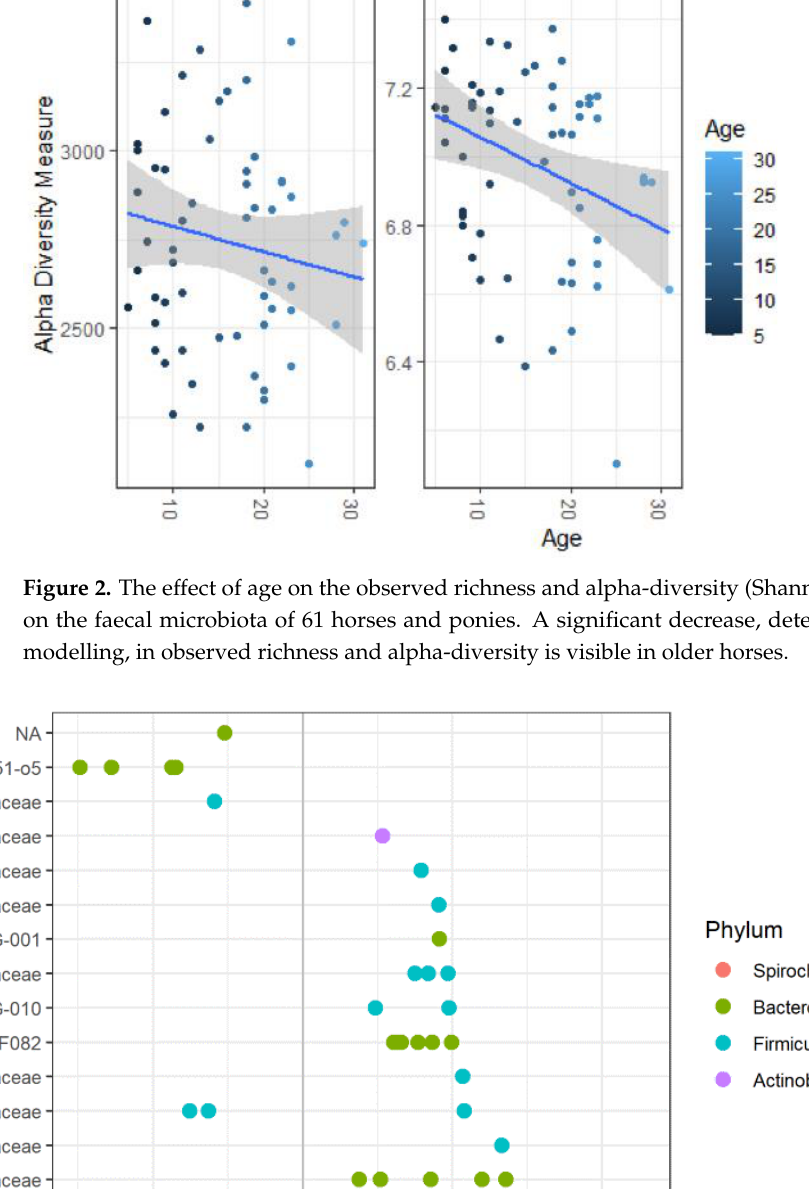
Figure 3. Differentially abundant ASVs grouped by family for increasing age (by year) of the faecal microbiota in 61 horses and ponies. The log2 fold change (per year) in ASV abundance is shown on the x -axis. ASVs assigned to bacterial families on the left side of the plot are less abundant in horses with increasing age. ASVs assigned to families depicted on the right side of the plot are more abun- dant in horses with increasing age. NA = ASV belonging to an unknown family (colours indicate the phylum).